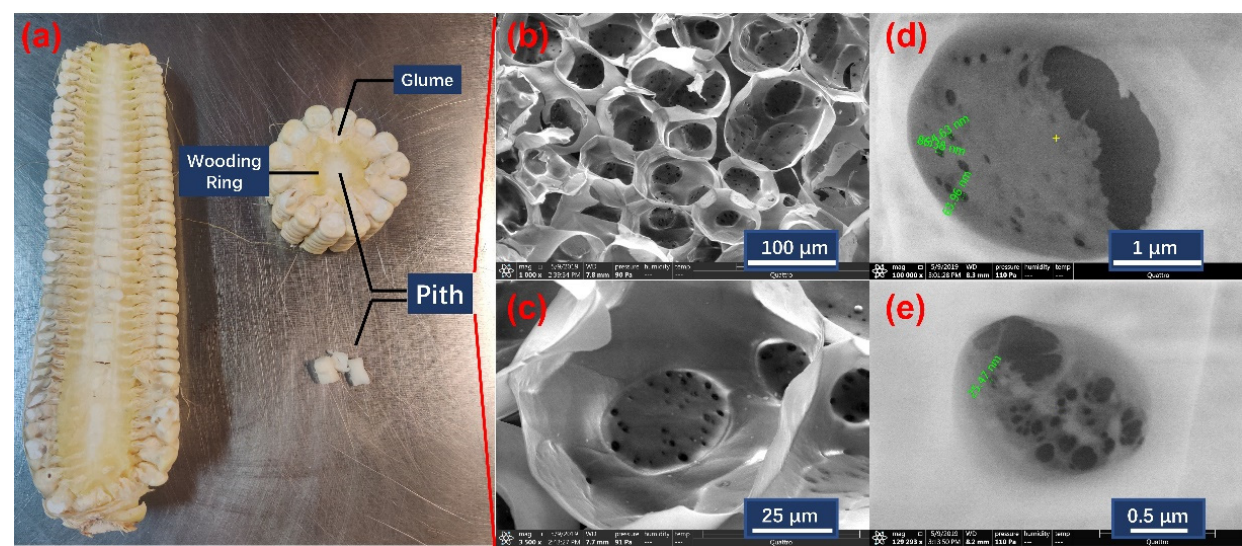
Figure 2. ( a ) Macrostructure of corn cob; ( b ) Microscopic bundle structure of the corncob pith sample; ( c ) Dark oval − like areas on the walls of bundles; ( d , e ) Nanopores in the dark oval-like areas.